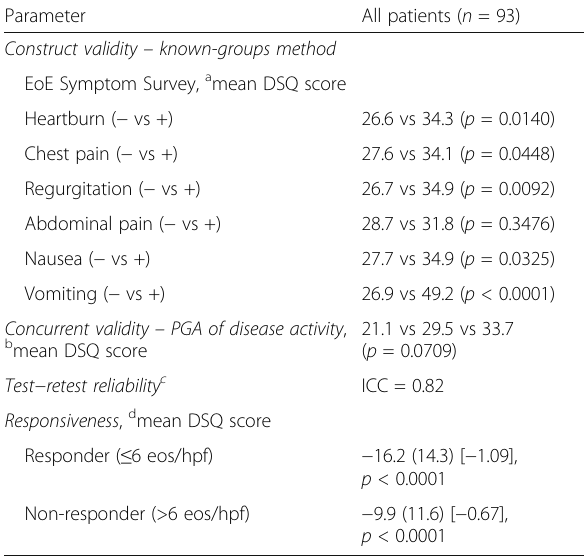
Table 4 Stage 2: Psychometric evaluation of the DSQ (version 4.0) to assess the construct validity, concurrent validity, reliability and responsiveness of the DSQ in patients with EoE at baseline (visit 2)